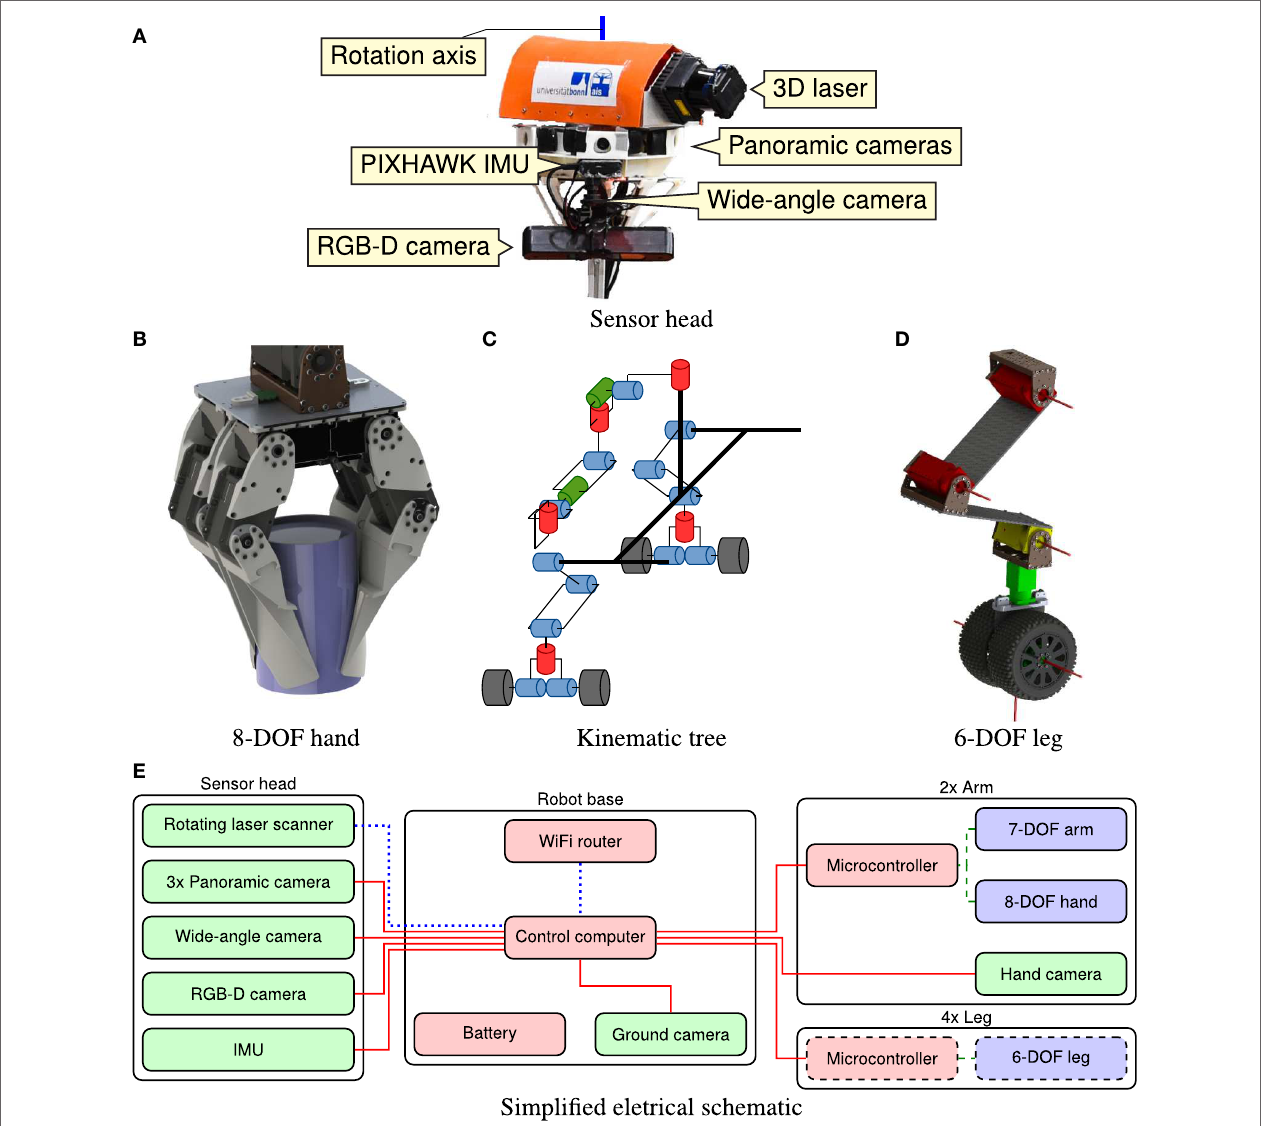
FIGURE 3 | Hardware components . (A) Sensor head carrying 3D laser scanner, IMU, four cameras, and an RGB-D camera. (B) The 8-DOF hand has specialized fingers for grasping the objects. (C) Kinematic tree of one half of Momaro. The hand is excluded for clarity. Proportions are not to scale. (D) The front left leg. The red lines show the axes of the six joints. (E) Simplified overview of the electrical components of Momaro. Sensors are colored green, actuators blue, and other components red. We show USB 2.0 data connections (red), LAN connections (dotted, blue), and the low-level servo bus system (dashed,